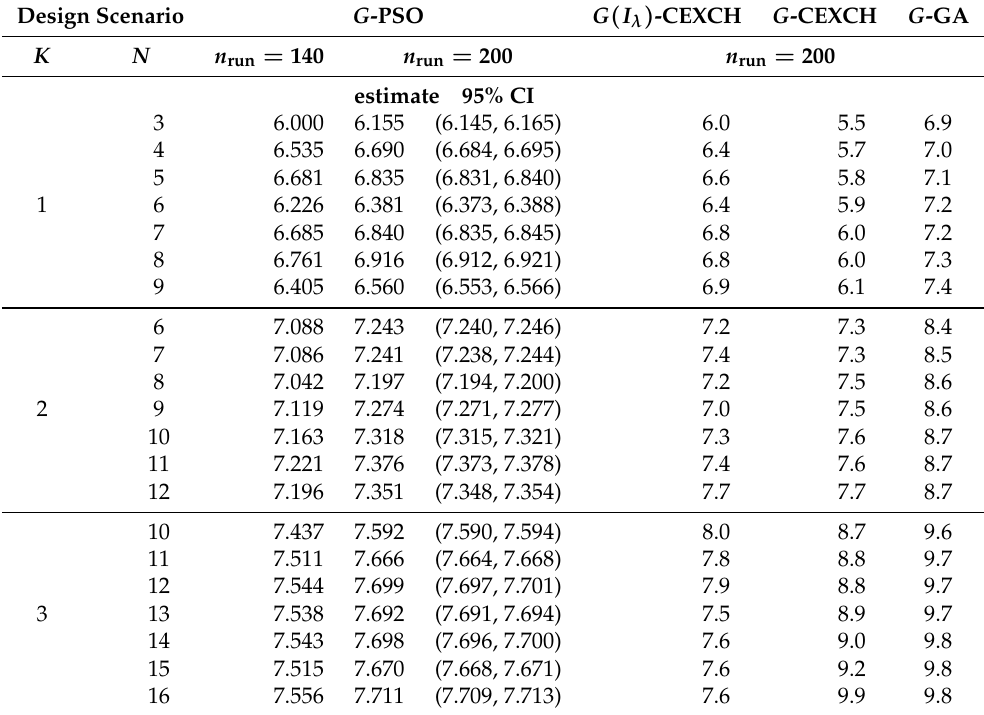
Table 3. Algorithm cost comparison to values reported by [11]. Table value is log10(# f evaluations). The first PSO column reports the observed number of function evaluations in 140 runs of PSO. The PSO columns report an estimate of the expected number of function evaluations in 200 PSO runs with a 95% confidence